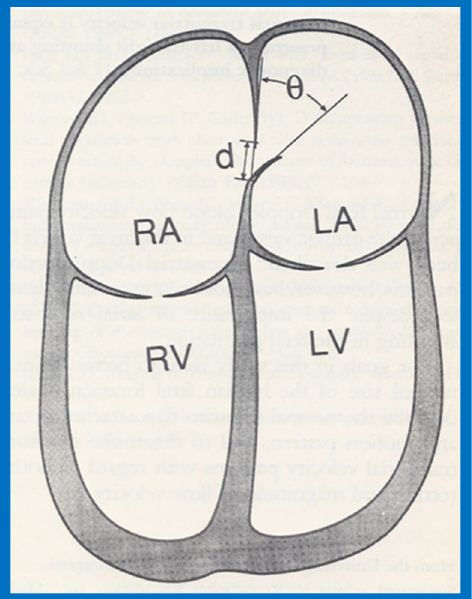
Figure 59. Drawing of the fetal heart demonstrating how the measurements are secured. Diameter (d) of the patent foramen ovale, as measured is shown. The angle ( θ ) is measured at the origin of the flap of foramen ovale with the atrial septum. The angle varied between 30 and 50 degrees; it was at least 30 degrees in all fetuses. LA: left atrium; LV: left ventricle; RA: right atrium; RV: right ventricle. Reproduced from Wilson AD, Rao P.S., Aeschlimann S. [19].